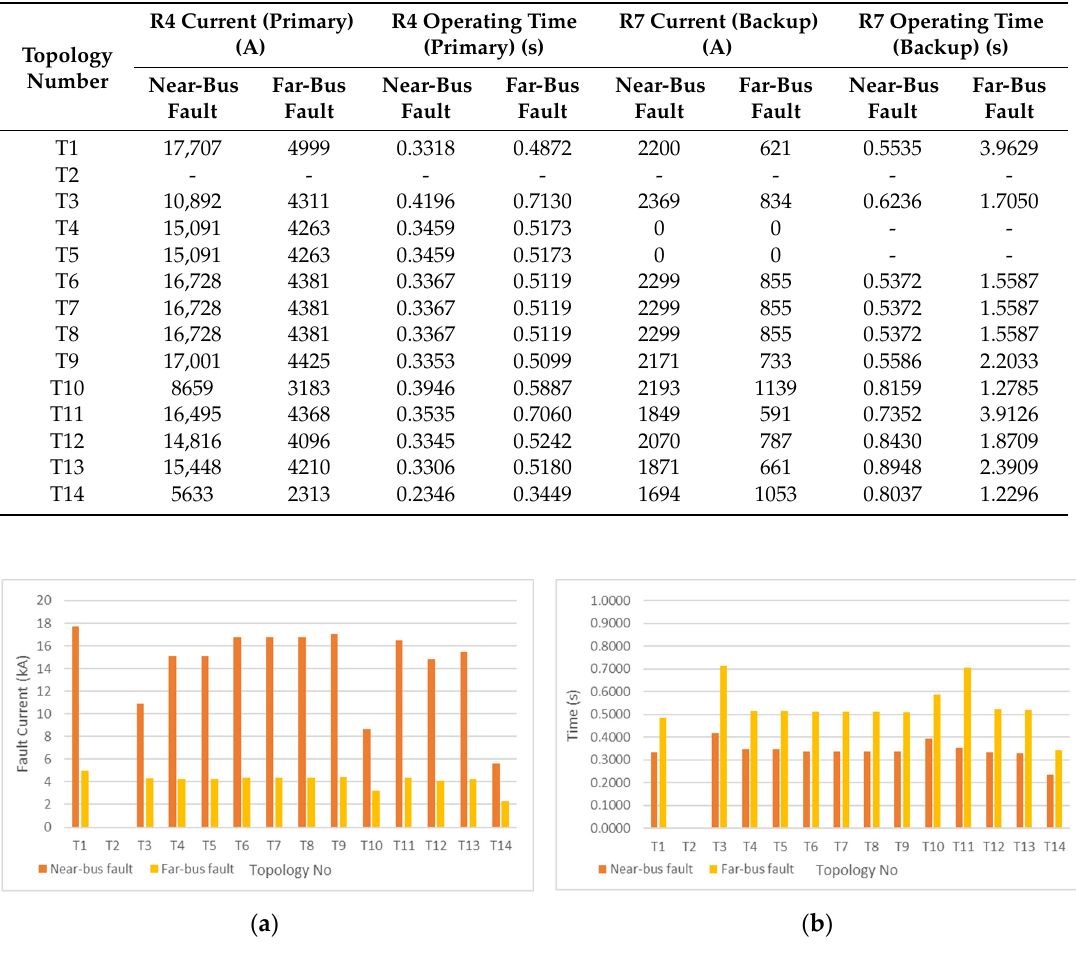
Figure 5. ( a ) Current seen by primary R4 for both near-end and far-end faults; ( b ) R4 primary operating times for both near-end and far-end faults.